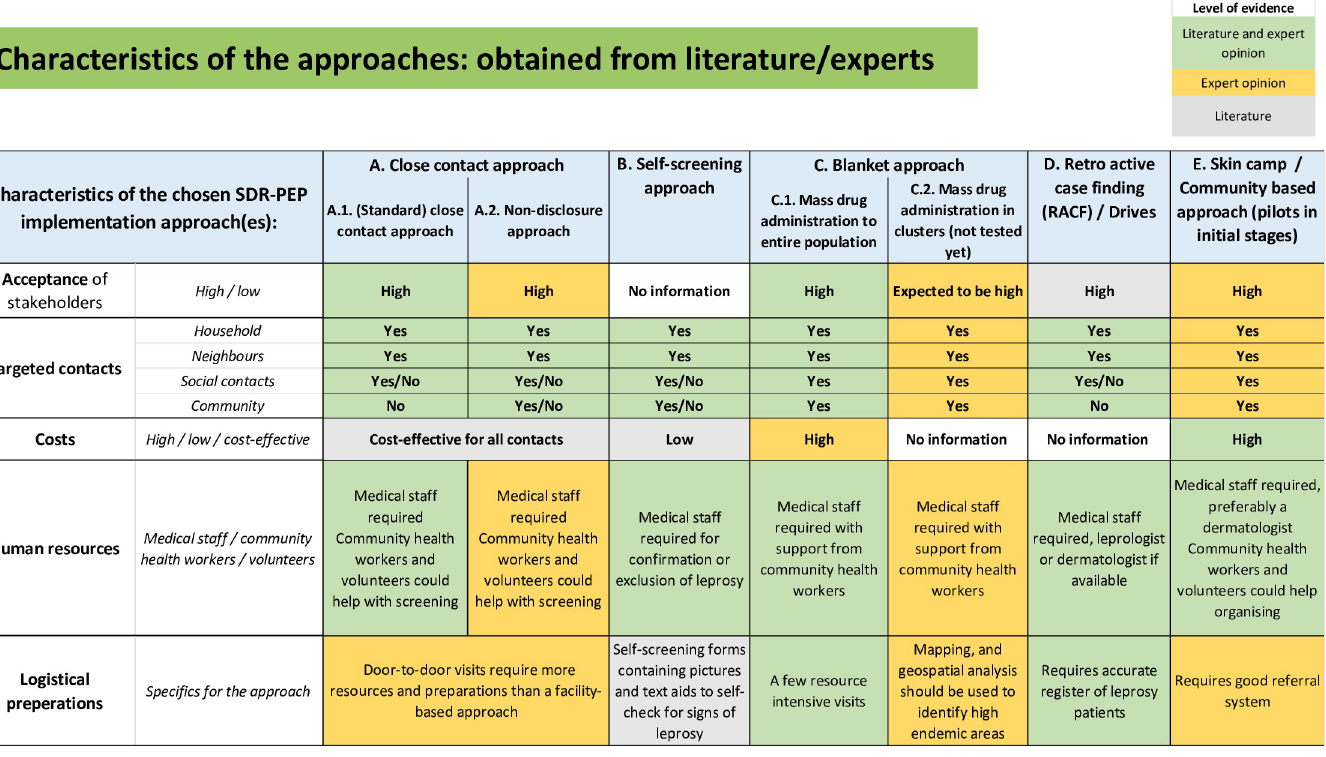
Fig 3. Characteristics of the approaches: obtained from